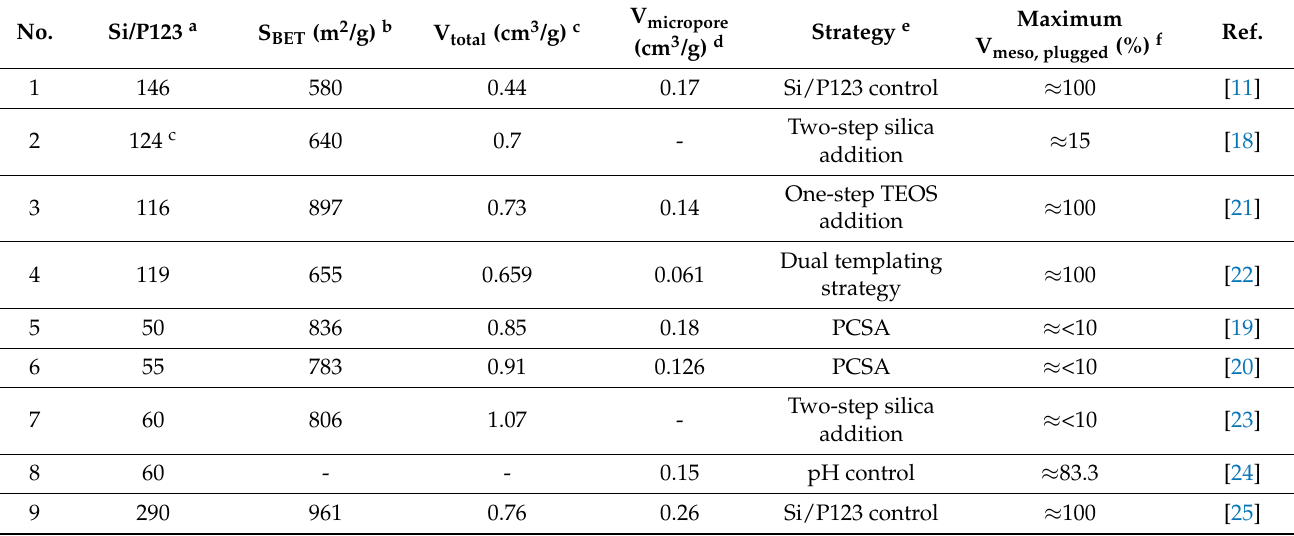
Table 1. Summary of various strategies to control the plugging of SBA-15